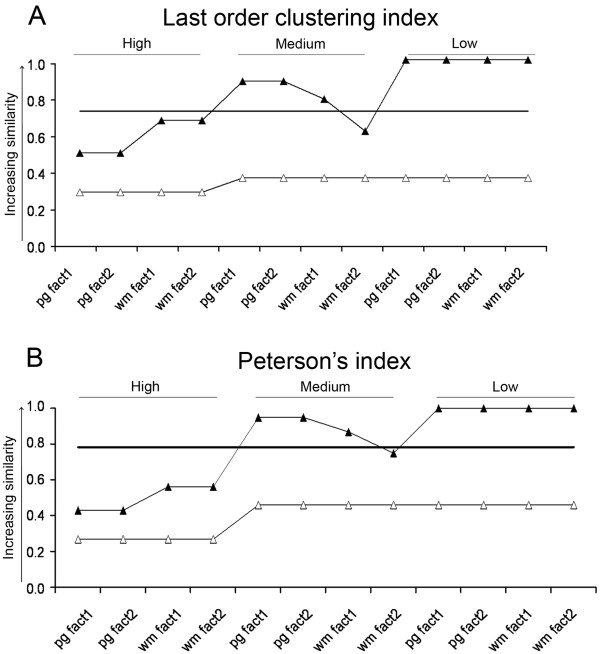
Grouping tendencies of MNs based on steady-state voltage- and current transfers (open and closed triangles). ‘High’, ‘Medium’, and ‘Low’ levels of synaptic background activities on dendrites were modeled by 5000, 20000 and 50000 Ωcm2 specific dendritic membrane resistivities respectively. To reveal grouping tendencies cluster analysis was used with the Pair group and Ward’s methods (see horizontal labels starting with ‘pg’ and ‘wm’) with differently weighted (‘fact1’ and ‘fact2’) descriptors. The five descriptors were the 10th, 25th, 50th, 75th, and 90th percentiles of standardized and area weighted distributions of voltage and current transfers between dendritic points and the soma. The two sets of weighting factors of percentiles (‘fact1’ and ‘fact2’) were as follows: In factor set 1, the 10th and 90th percentiles were weighted by 0.2 and the 25th and 75th percentiles by 0.8. In factor set 2, the weighting factors were 0.33 for the 10th and 90th percentiles and 0.67 for the 25th and 75th percentiles. In both sets of weighting factors the weight was 1 for the 50th percentile. In cluster analyses the Euclidian distances were used. Homogeneity indexes, last order clustering index (A) and Peterson’s index (B), were used to measure segmental homogeneities of MNs within last order clusters, which reflect segregation of cervical and lumbar MNs between the clusters. Homogeneity indexes with values closer to one indicate higher similarity (poorer segregation) of cervical and lumbar MNs. Continuous horizontal lines mark the levels of homogeneity indexes below which segmental separation of MNs by their voltage and current transfer properties is significant.